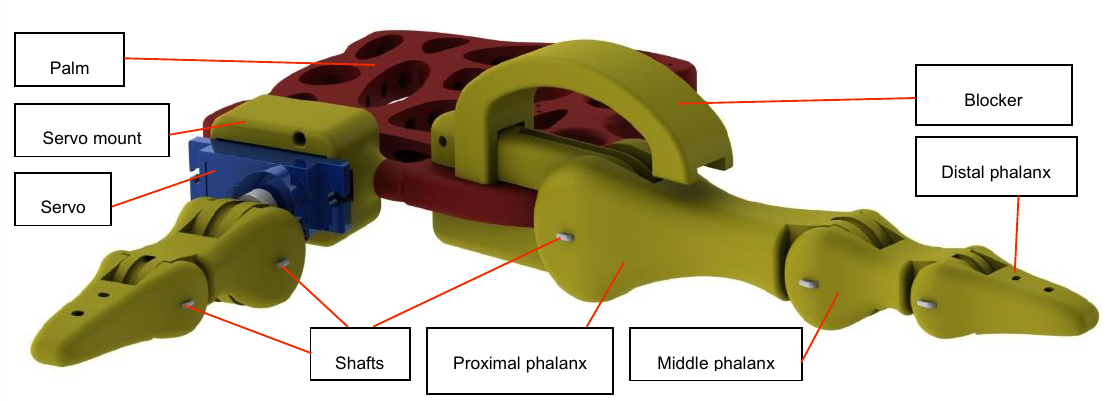
Figure 1. Phalanges Assembly.